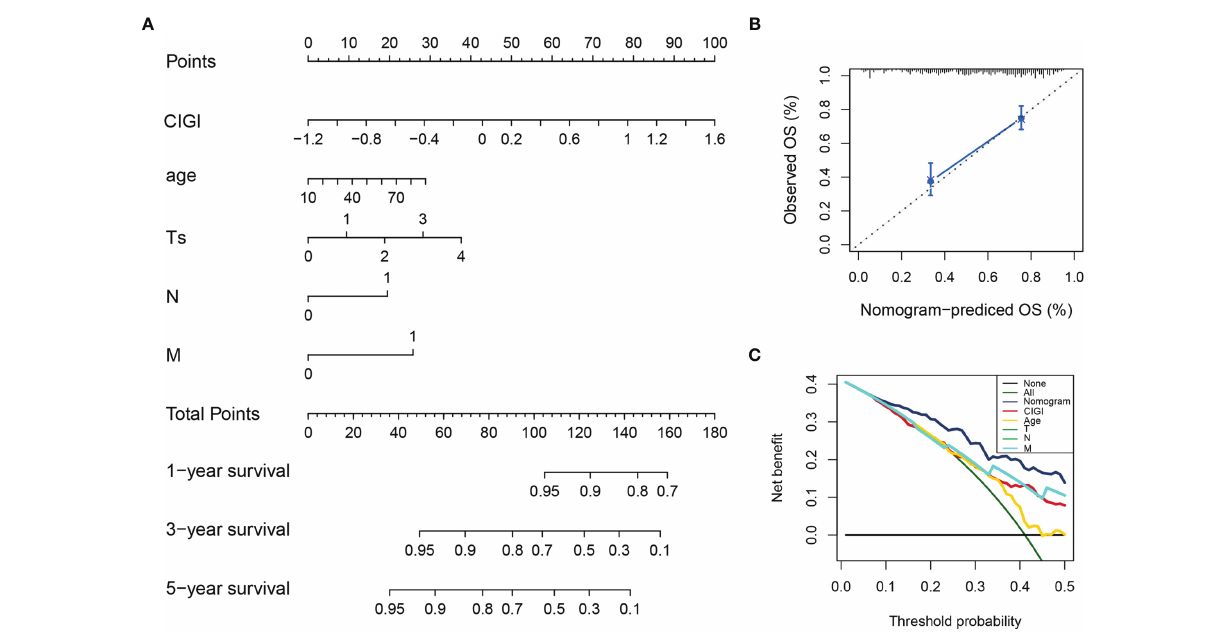
FIGURE 6 | Construction and validation of the nomogram model. (A) Nomogram model combining CIGI and traditional clinical features. (B) Five-year calibration curves of the nomogram model. (C) DCA of the nomogram